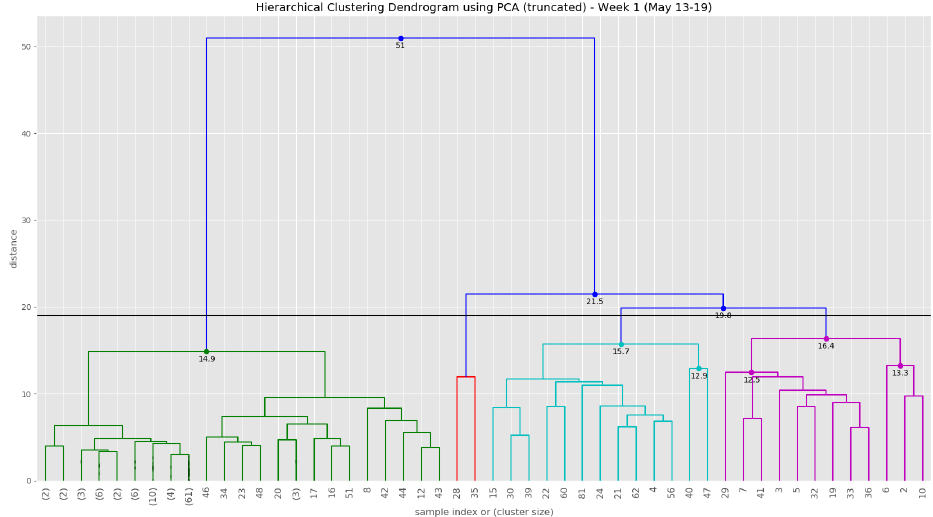
Figure 15. The dendrogram of the first observation week for the top 5 principle